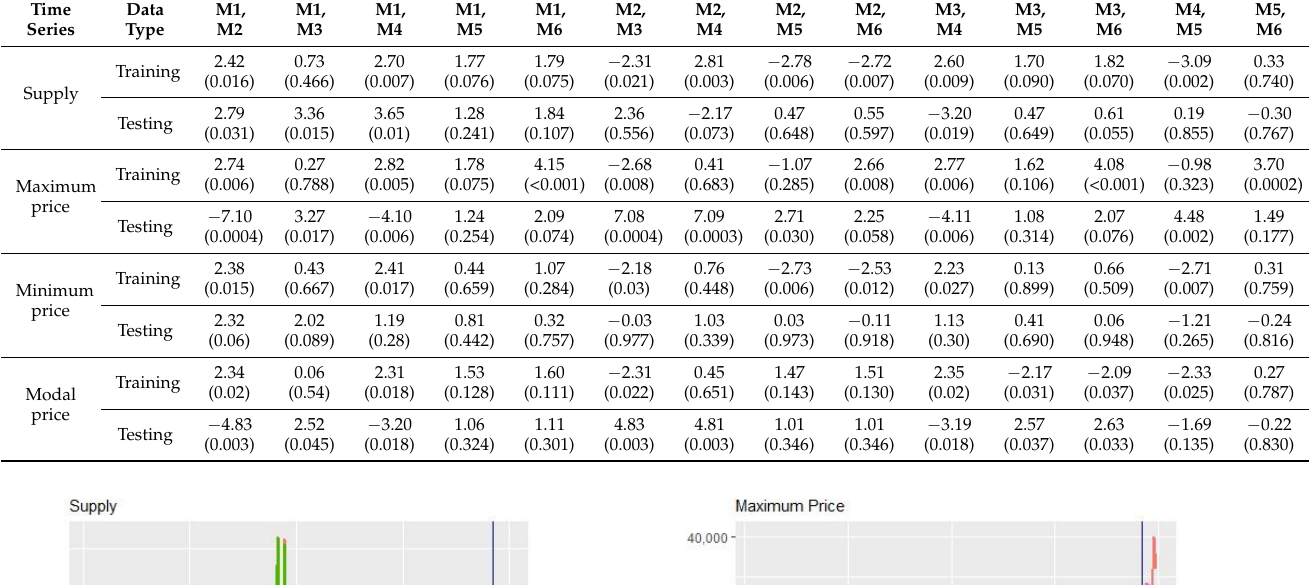
Table 8. Diebold–Mariano test for significance comparison of different models in training and testing data sets.